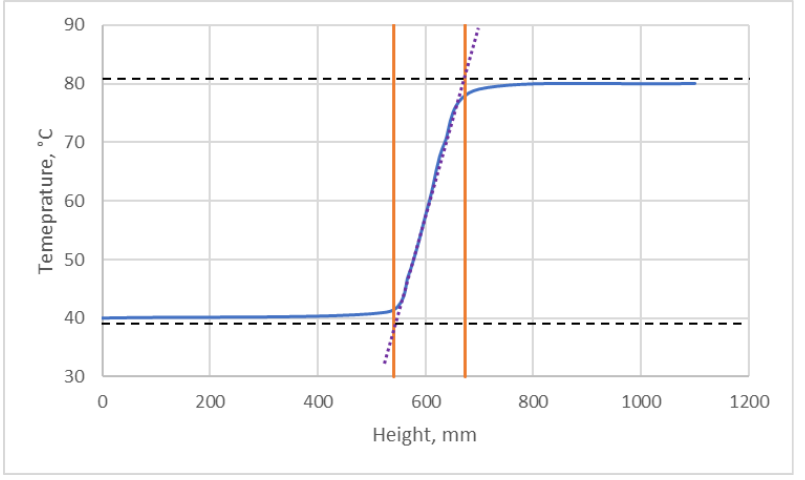
Figure 8. Temperature distribution as a function of the height of the tank (blue line) and the adopted limits of the thermocline (orange lines).